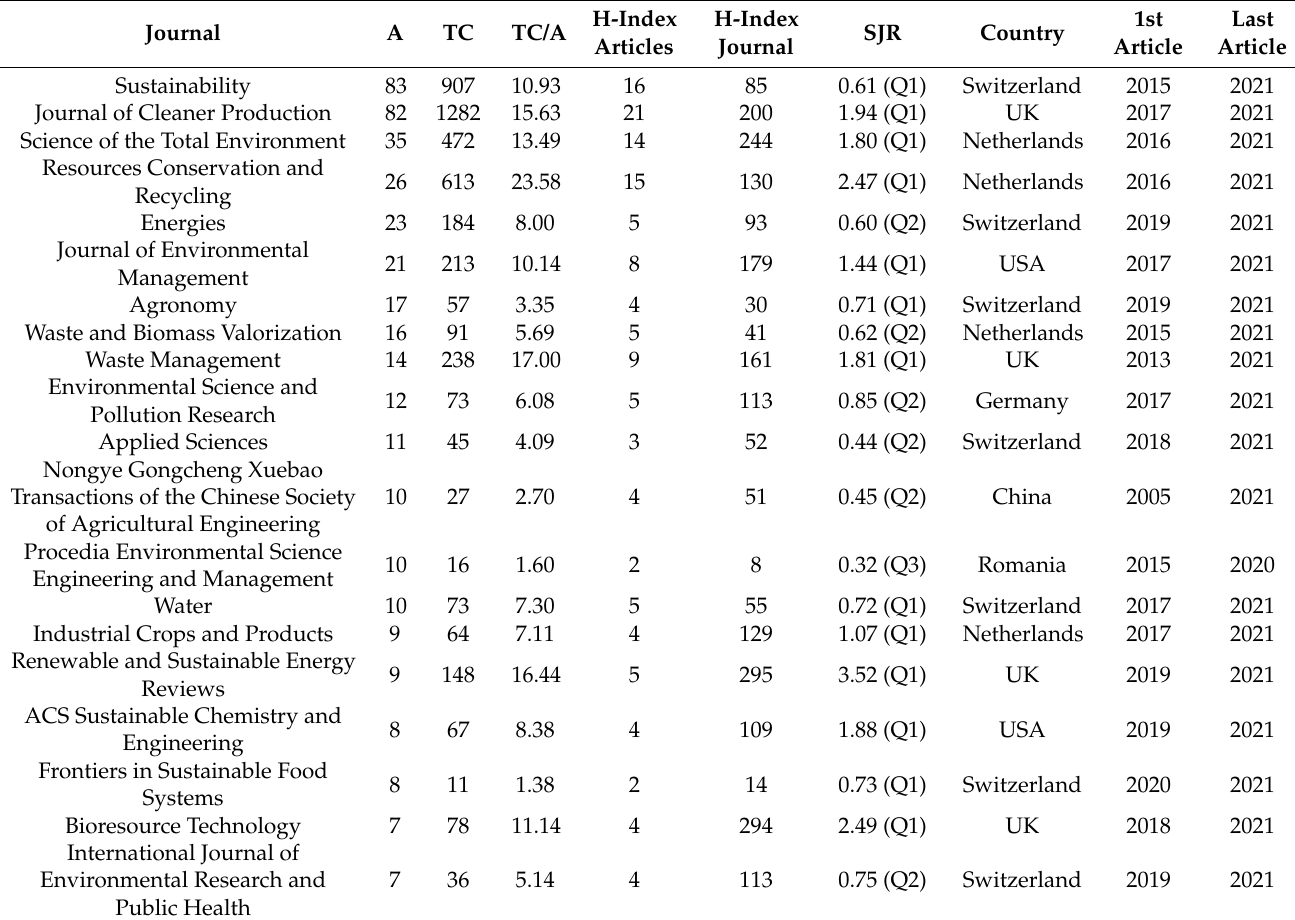
Table 2. The most active journals in CE and agriculture research